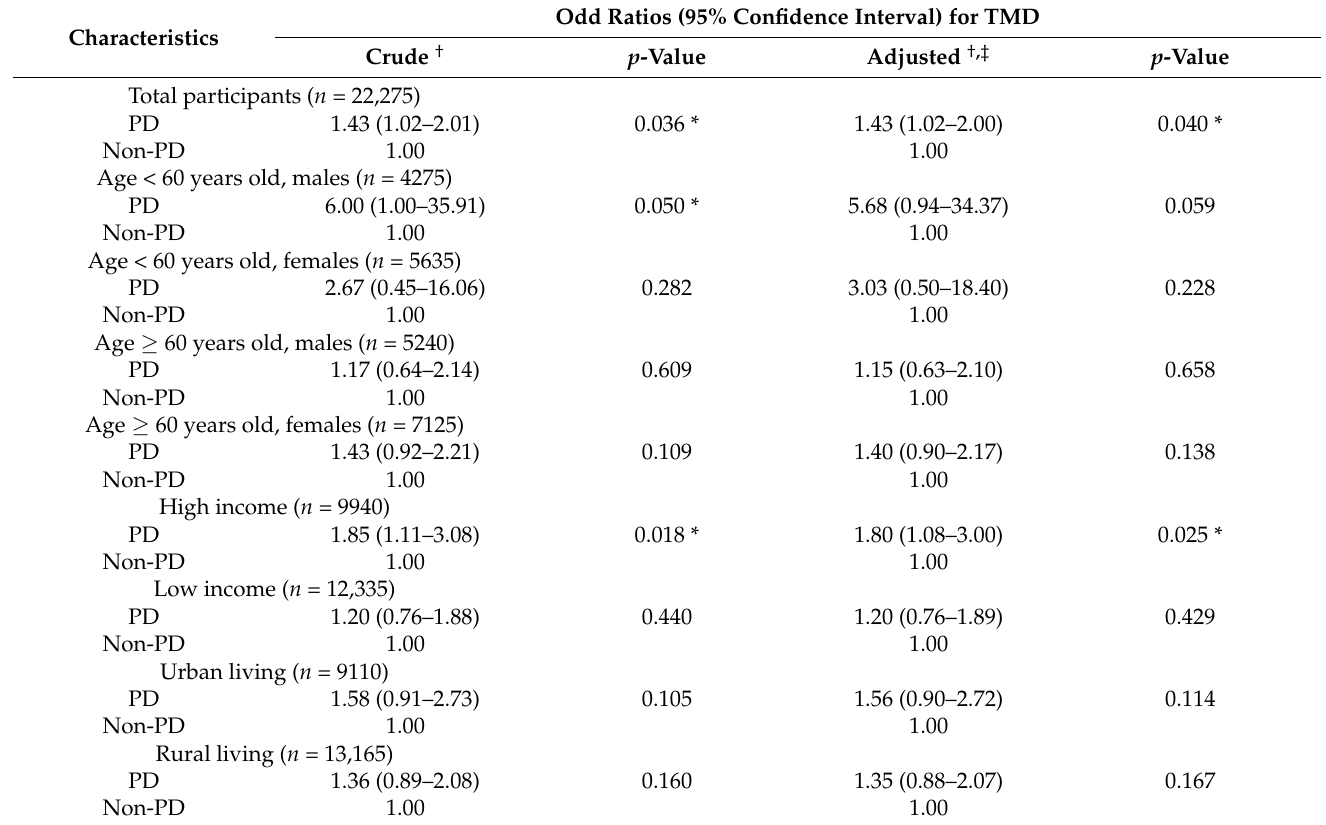
Table 2. Odd ratios for TMD in PD and non-PD groups in Study I.